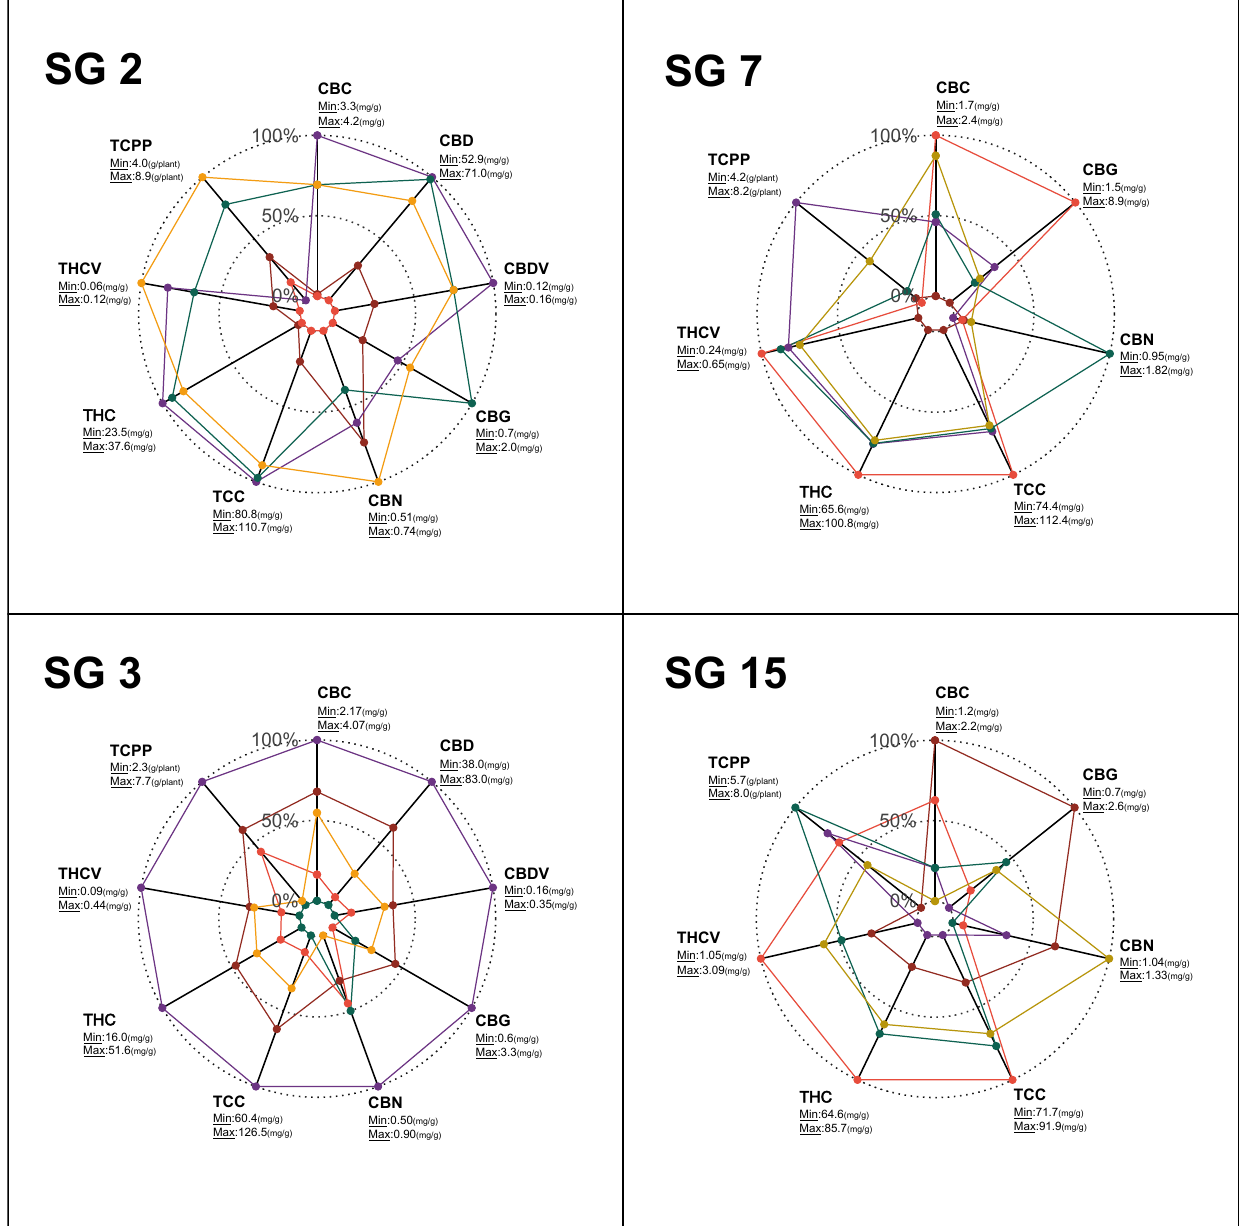
Figure 4. Radar charts for the relative quantities of cannabinoids across 4 vernacularly classified strain groups. Strain Group 2 (SG 2), Durga Mata (blended CBD:THC); Strain Group 3 (SG 3), Nebula (blended CBD:THC); Strain Group 7 (SG 7), Ice Cream (high THC); Strain Group 15 (SG 15), White Berry (high THC). Colours within each strain group indicate the genotypic replicate’s mean value for each parameter. The absolute range of the cannabinoid quantities, minimum (0%) and maximum (100%), across genotypes within each strain group is depicted next to the parameter indication. Abbreviations: strain group